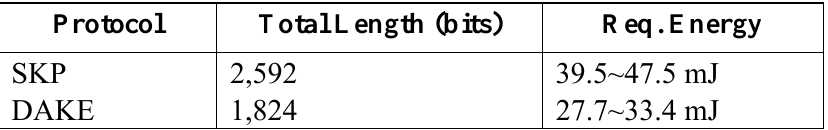
Table 6. The comparisons of Energy Cost.